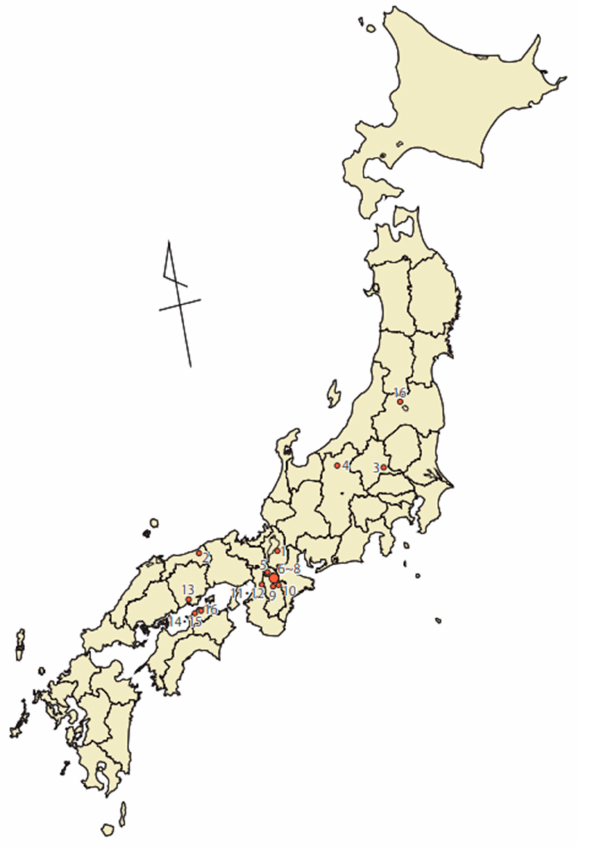
Figure 5. Stone Pagoda distribution map.